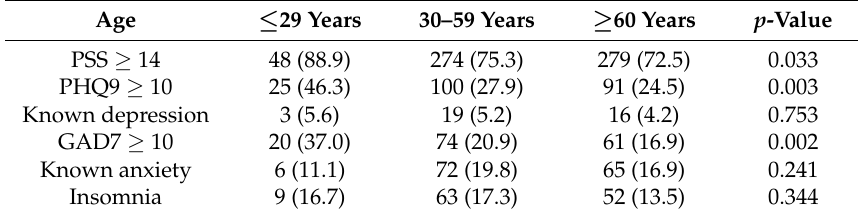
Table 2. Association between age group and psychiatric illness 1 .